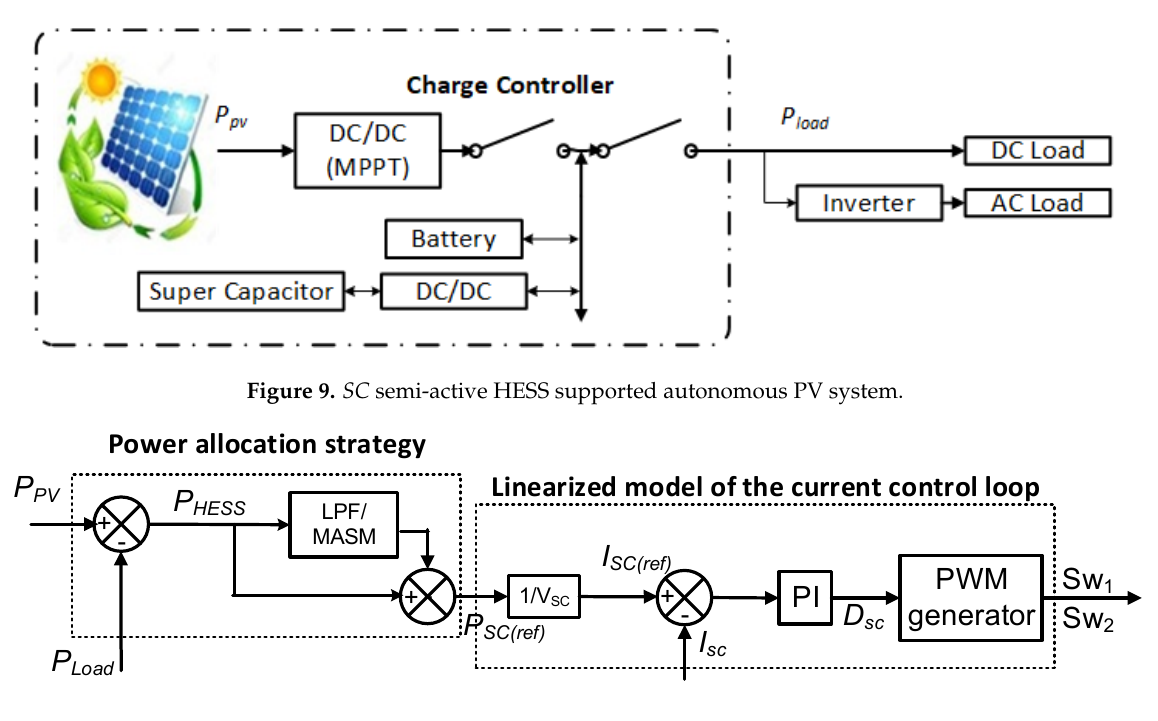
Figure 10. Power allocation scheme in SC semi-active HESS.